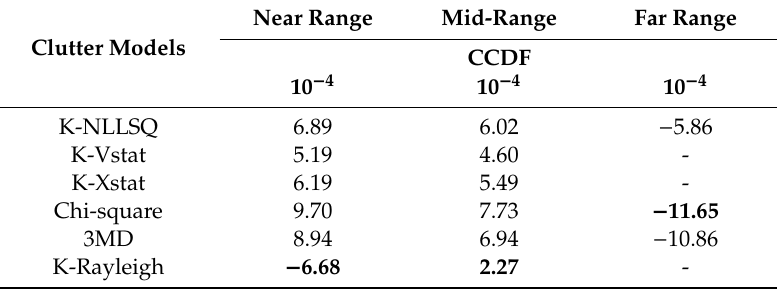
Table 4. Estimated threshold error for di ff erent clutter models for circularly acquired F-SAR data.